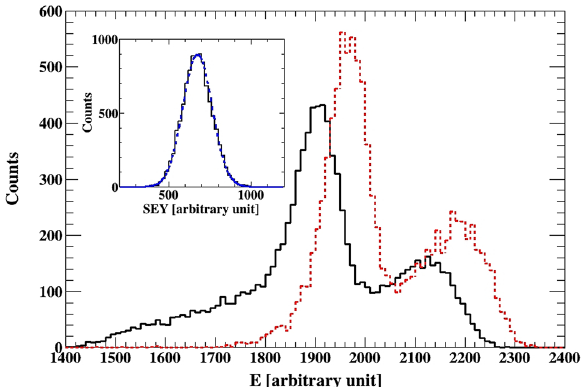
Figure 2. Energy spectrum measured with the Si detector for Au and ZnO / GaN samples. The ZnO / GaN data is shown with the black unbroken line. The data from the Au sample is shown with the red dashed line. See text for further details. The inset shows the SEY measured from the Si 3 N 4 foil covered with 20 nm thick layer of gold. It is fitted with a normal distribution. The peak is well described by the fit pointing to a single source of secondary